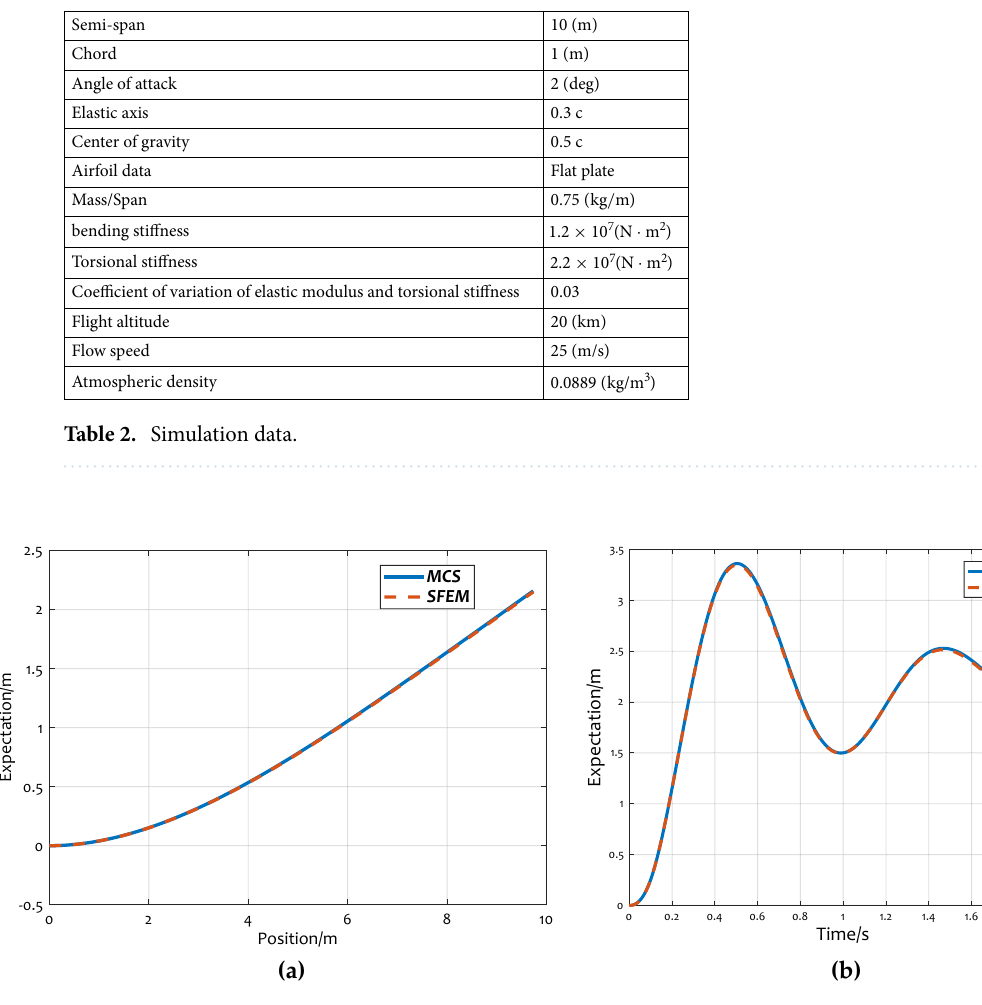
Figure 5. Comparison of displacement expectations: ( a ) displacement at different locations; ( b ) displacement expectations at different